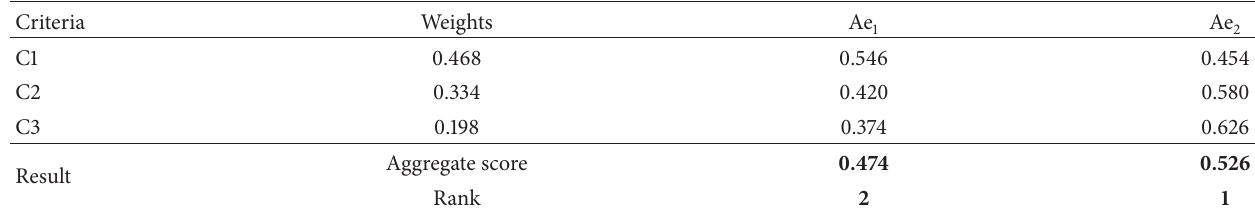
Table 2: The overall weight to select the business